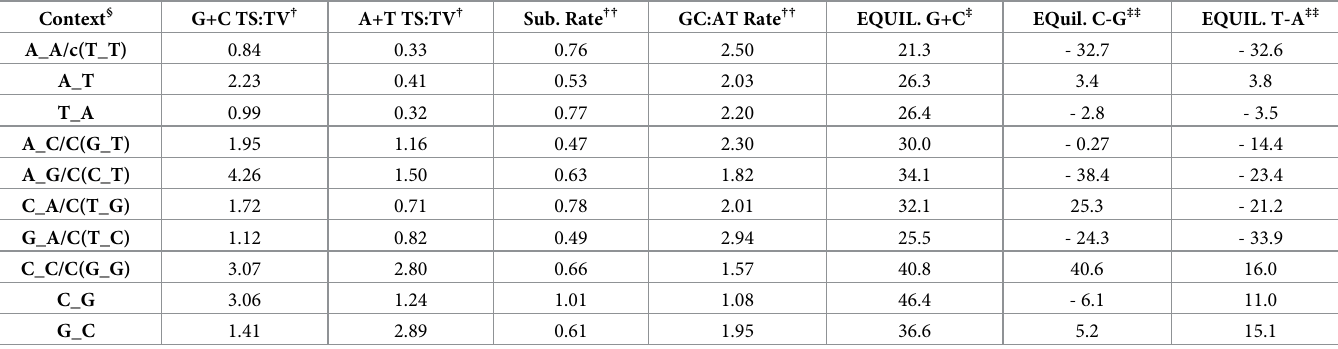
Table 1. Context-dependent properties of the MC2020 model.